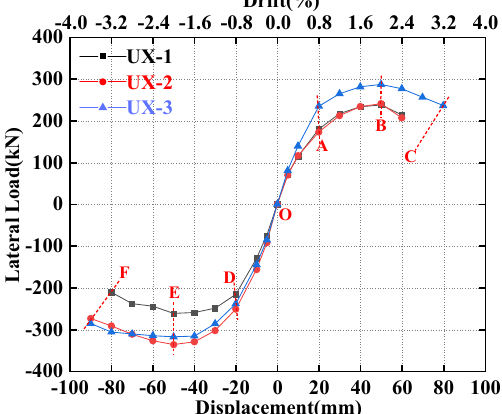
Figure 10. Skeleton curve for each specimen.